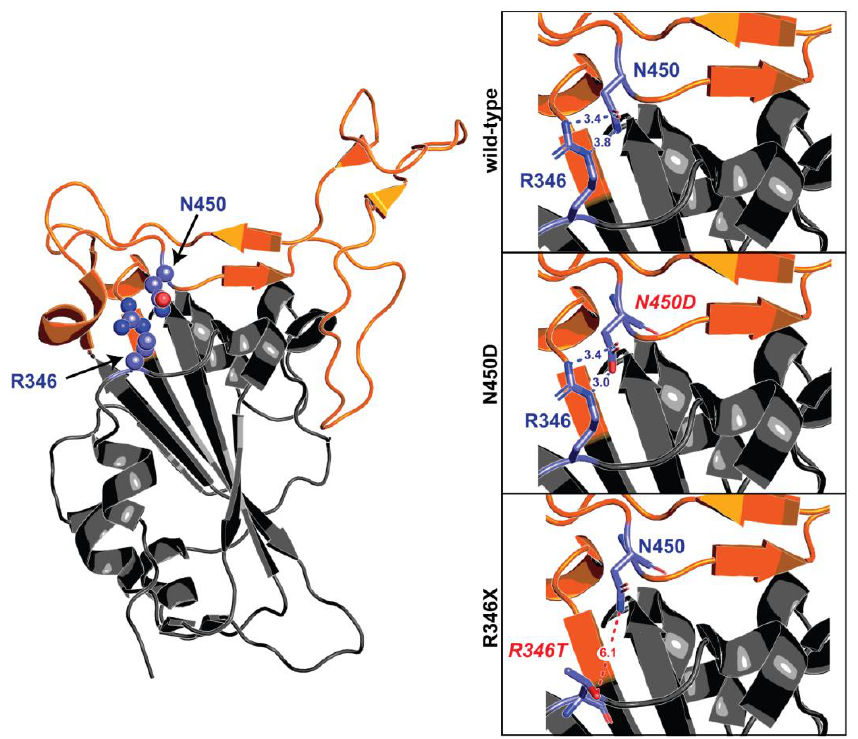
Figure 7. Mutually exclusive mutations at R346 and N450. The receptor binding domain of S is depicted in grey cartoon representation, with the receptor binding module (ACE2 interaction interface) highlighted in orange. Amino acids at the 346 and 450 positions are displayed as purple sticks. A zoomed-in view of the R346-N450 interaction in the ancestral domain, as well as the computationally modelled amino acid substitutions at those two positions, are portrayed in boxes